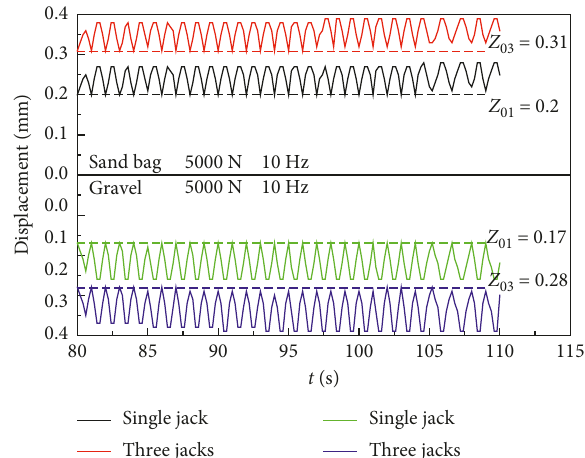
Figure 8: Rebound displacement Z